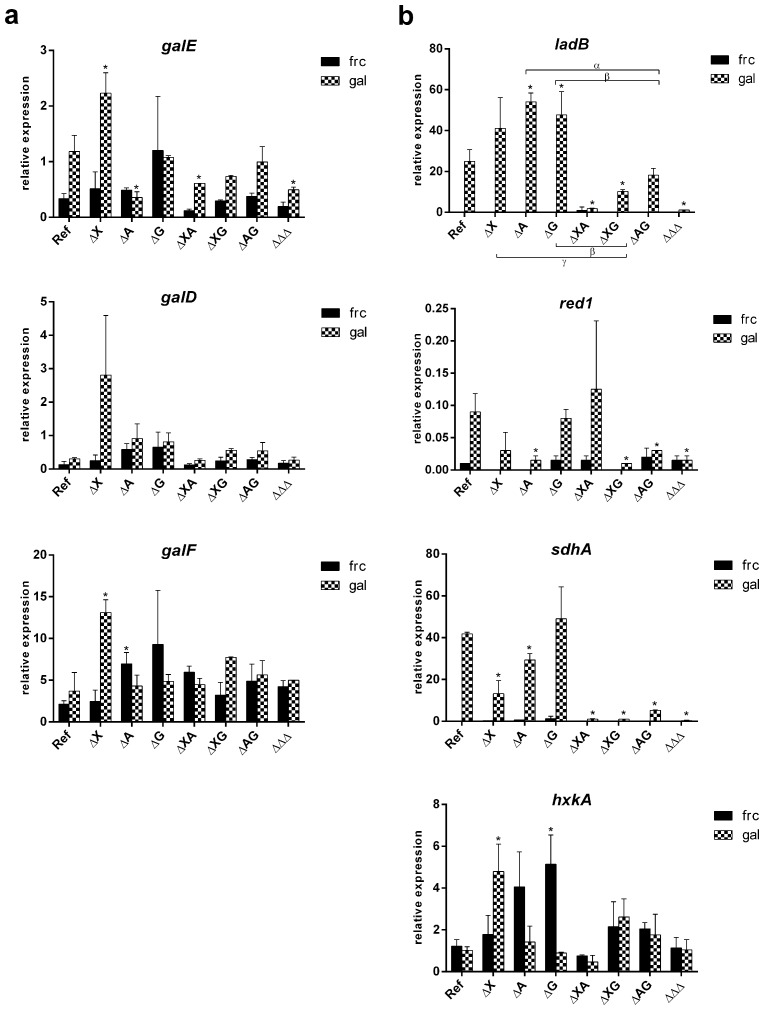
Expression of orthologous genes encoding enzymes involved in the Leloir (a) and the D-galactose oxido-reductive pathway (b) in A. niger.The expression was measured in the reference and regulatory mutant strains of A. nidulans after 2h of growth on D-fructose (black bars) and D-galactose (checkered bars). The columns represent the mean and error bars represent standard deviation between biological replicates. Significant change in expression between the reference strain and the mutant was marked by the asterisk. Significant changes in expression between single and double mutants were marked by Greek symbols and braces: an alpha (α) represents a significant change between ΔA and ΔAΔG, a beta (β) represents a significant change between ΔG and ΔXΔG/ΔAΔG, a gamma (γ) represents a significant change between ΔX and ΔXΔG.